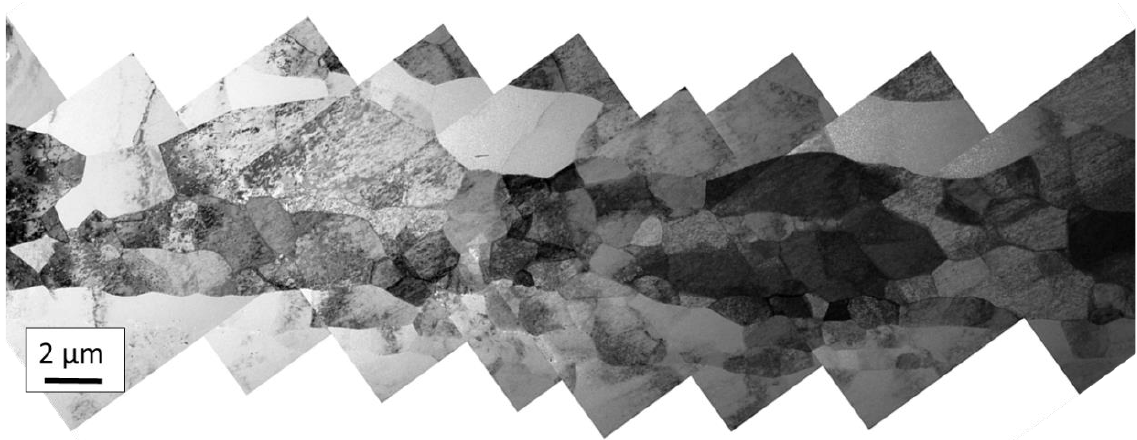
Figure 4. TEM micrograph displaying elongated and recrystallized granular morphology.